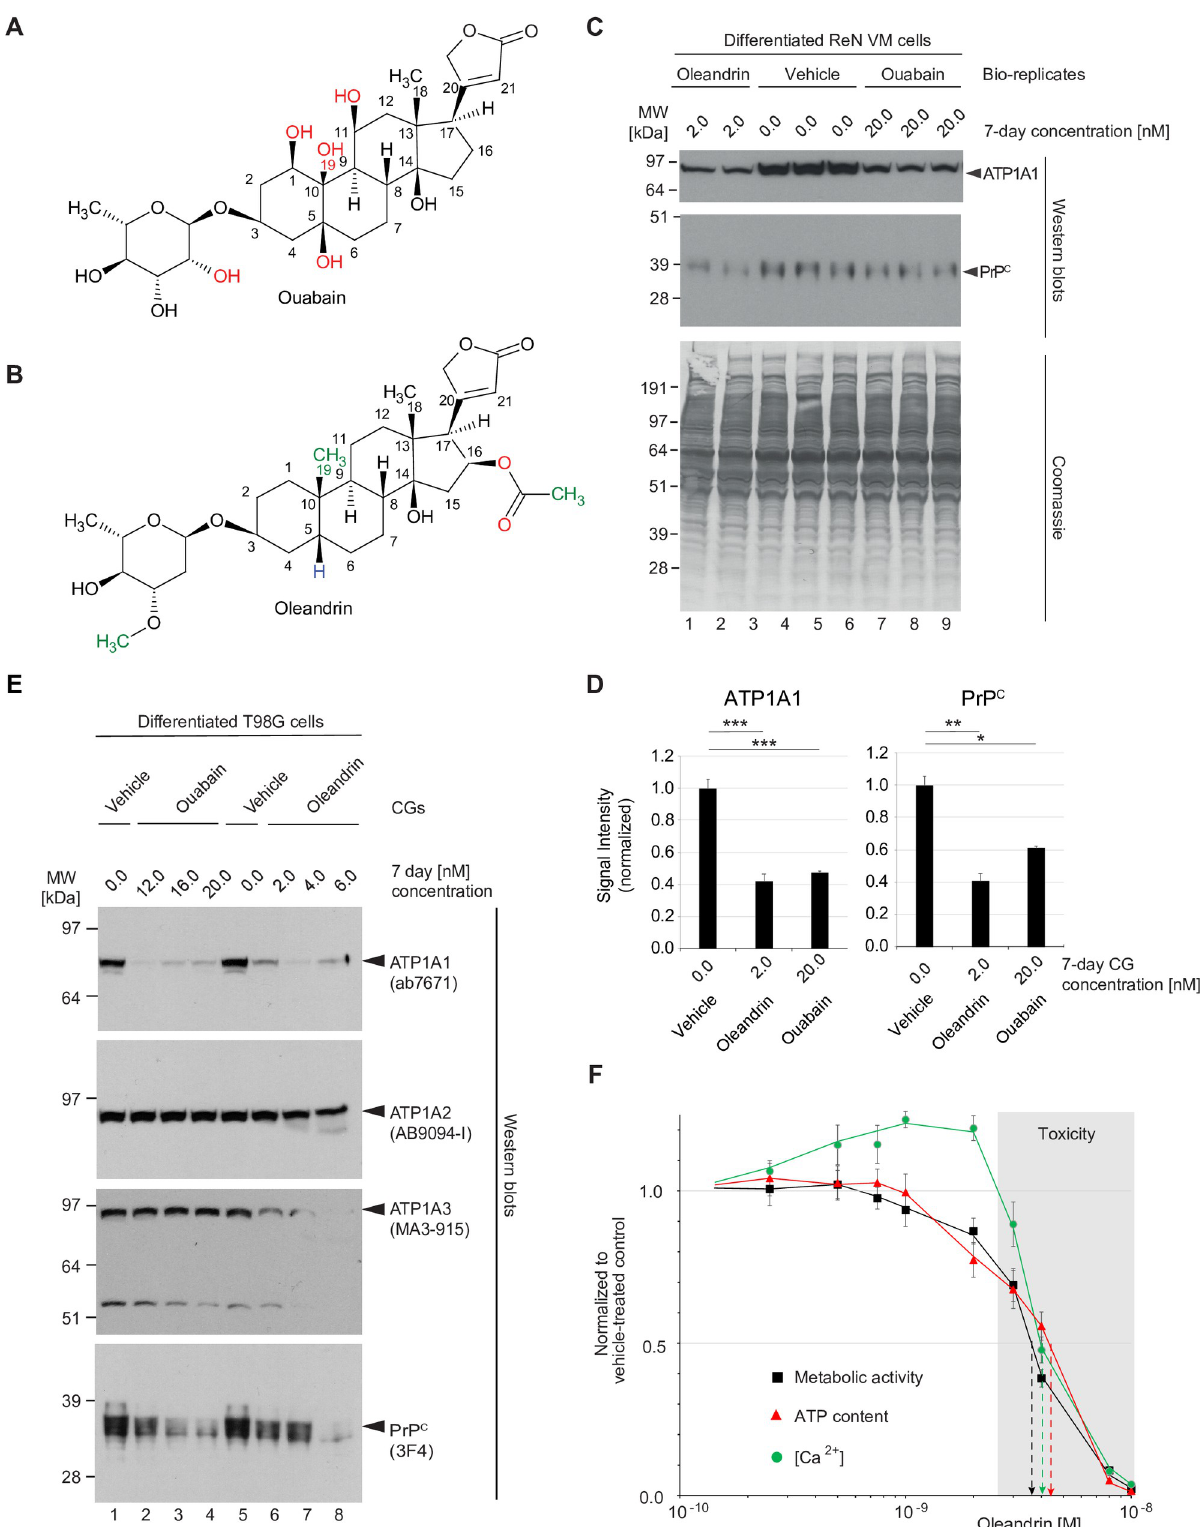
Fig 5. Oleandrin is a potent yet toxic CG for the NKA-mediated reduction of PrP C levels. Comparison of (A) ouabain, a cardiotonic steroid sourced from the Strophanthus gratus plant native to eastern Africa, and (B) oleandrin, found in Nerium oleander , an ornamental shrub of